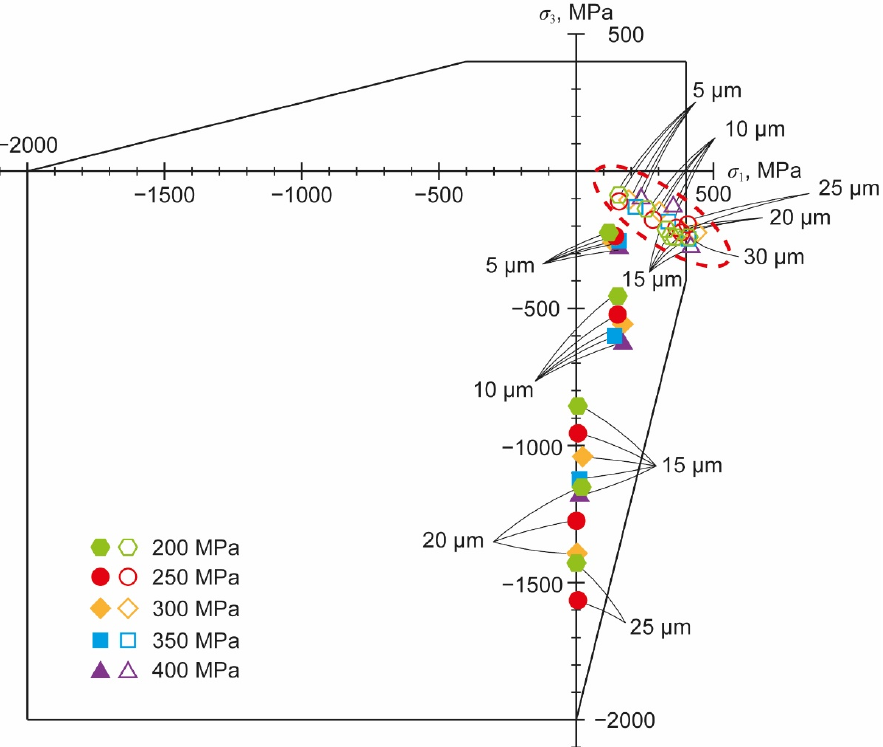
Figure 17. The failure envelope at the impact of iron–aluminum–silicate particles at different oper- ating pressures on the surface of a c -axis aligned sapphire.The values are derived from an explicit dynamic numerical calculation; the two principal stresses for the plane stress state at the times of the highest compressive stress (full symbols) and the highest tensile stress (outlined symbols) are shown.